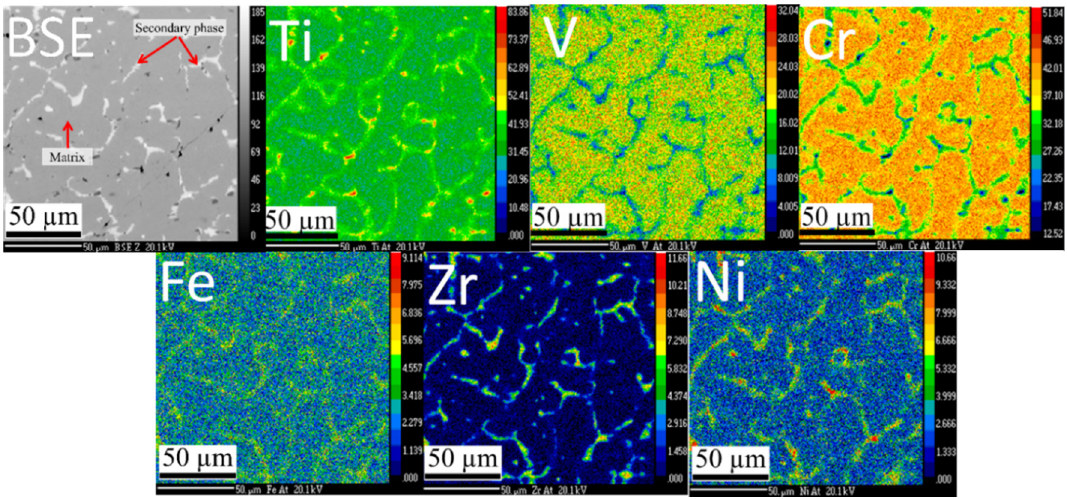
Figure 6. BSE SEM micrograph and Electron Probe Micro Analysis (EPMA) mapping of the as-cast